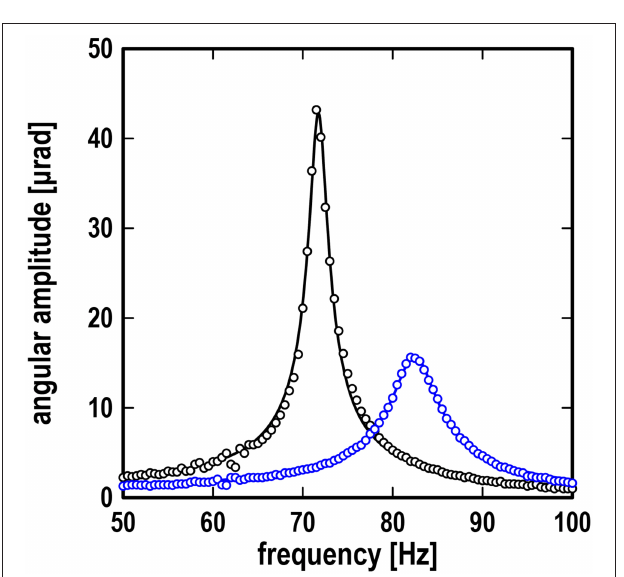
FIGURE 6 | Resonance curves showing frequency response of angular amplitude; black line: theoretical results for case I (no contact) or case III (fully slipping contact); blue line: theoretical result for case II (static contact) at W = 20N; red lines: numerical results for arbitrary case at W 0.5 mm/s; red symbols: experimental data at W